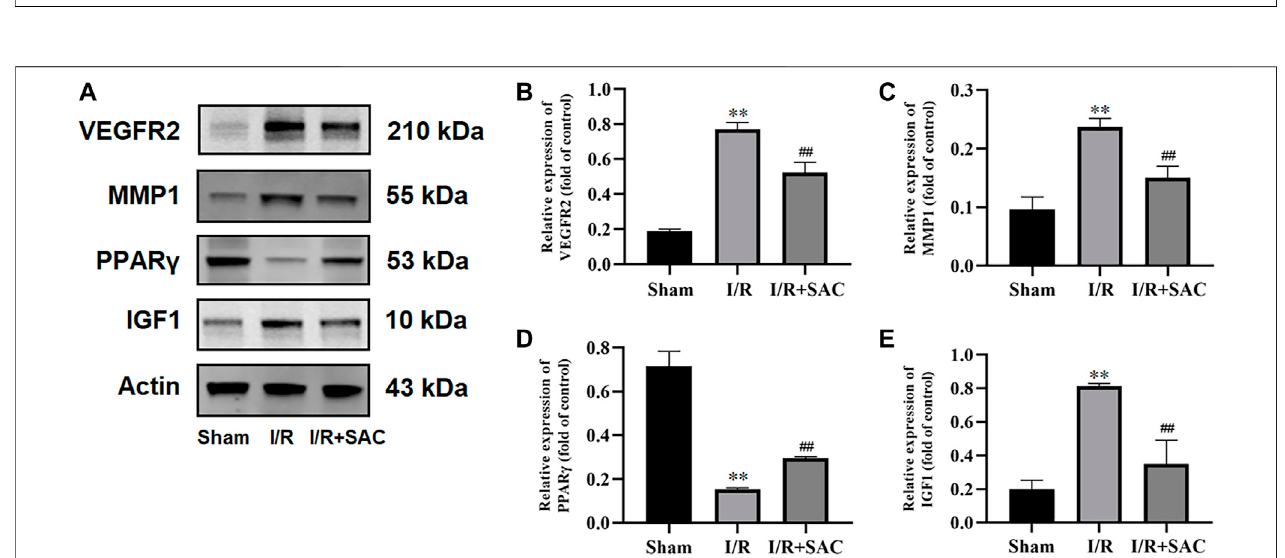
FIGURE 9 | Representative images from western blot for the proteins (A) and relative expression levels of VEGFR2 (B) , MMP1 (C) , PPAR γ (D) , and IGF1 (E) . ** p < 0.01, vs the sham group. # p < 0.05, ## p < 0.01, vs the I/R group (n = 3).